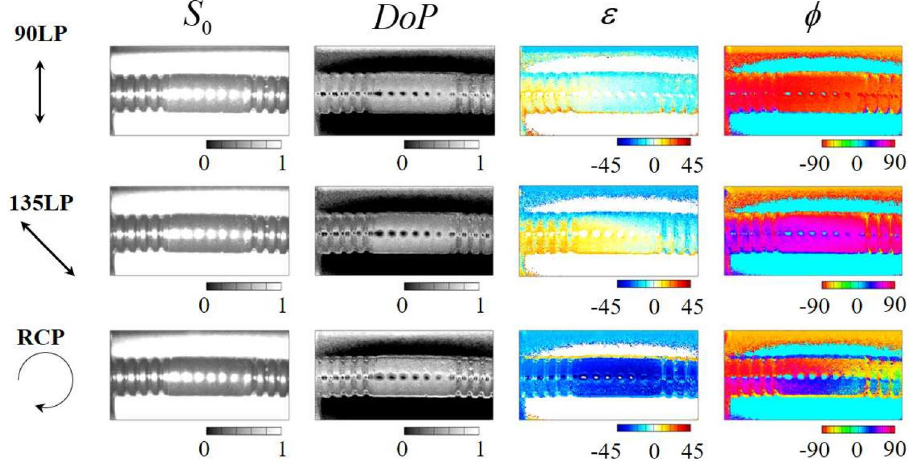
Figure 8. Intensity, degree of polarization, ellipticity angle, and azimuth angle calculated from the Stokes parameters of a black tube wrapped in black tape that were acquired using the PPPI